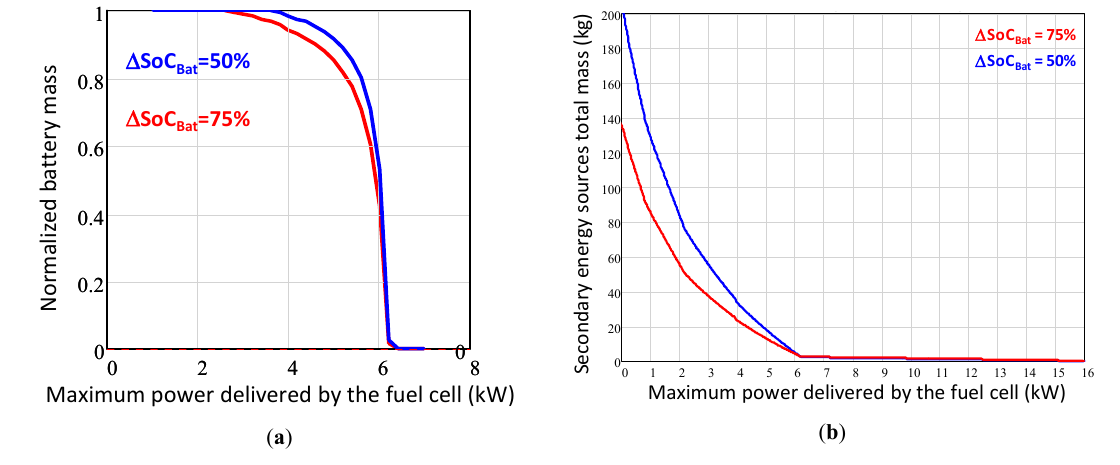
Figure 16. Identification of the optimal design power range for each group of architectures, depending on the variation in the state-of-charge of the battery. ( a ) Normalized battery mass. ( b ) Total mass of secondary energy sources.